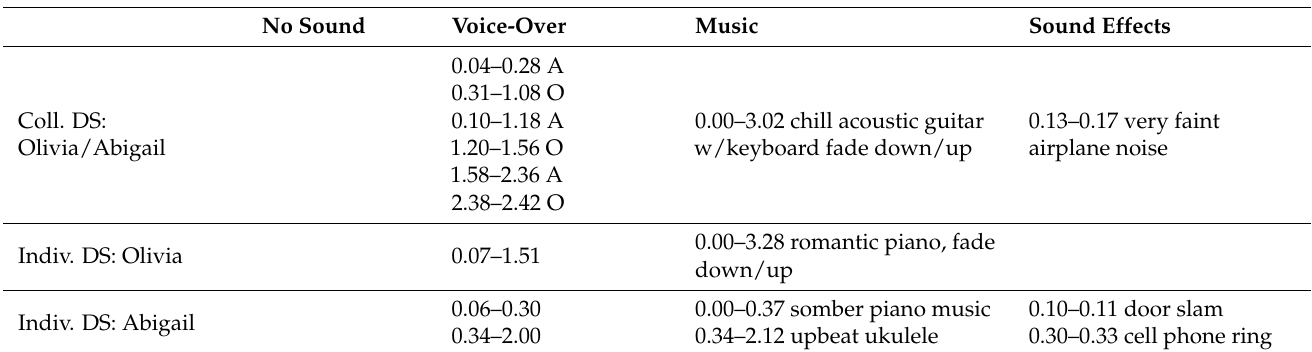
Table 4. Pair 5: example inventory of